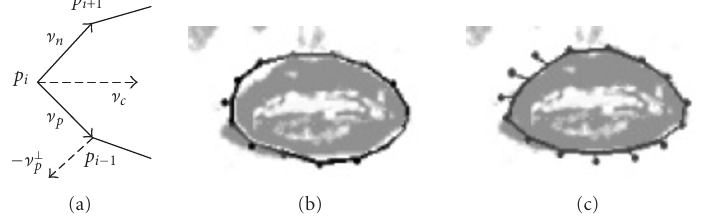
Figure 6: Lip contour detection. (a) Layout of control forces. (b) Contour after one iteration. (c) Contour after 12 iterations.